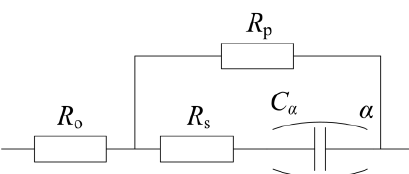
Fig. 1. Applied supercapacitor model including a fractional capacitor element (the symbol has been first introduced in [15])